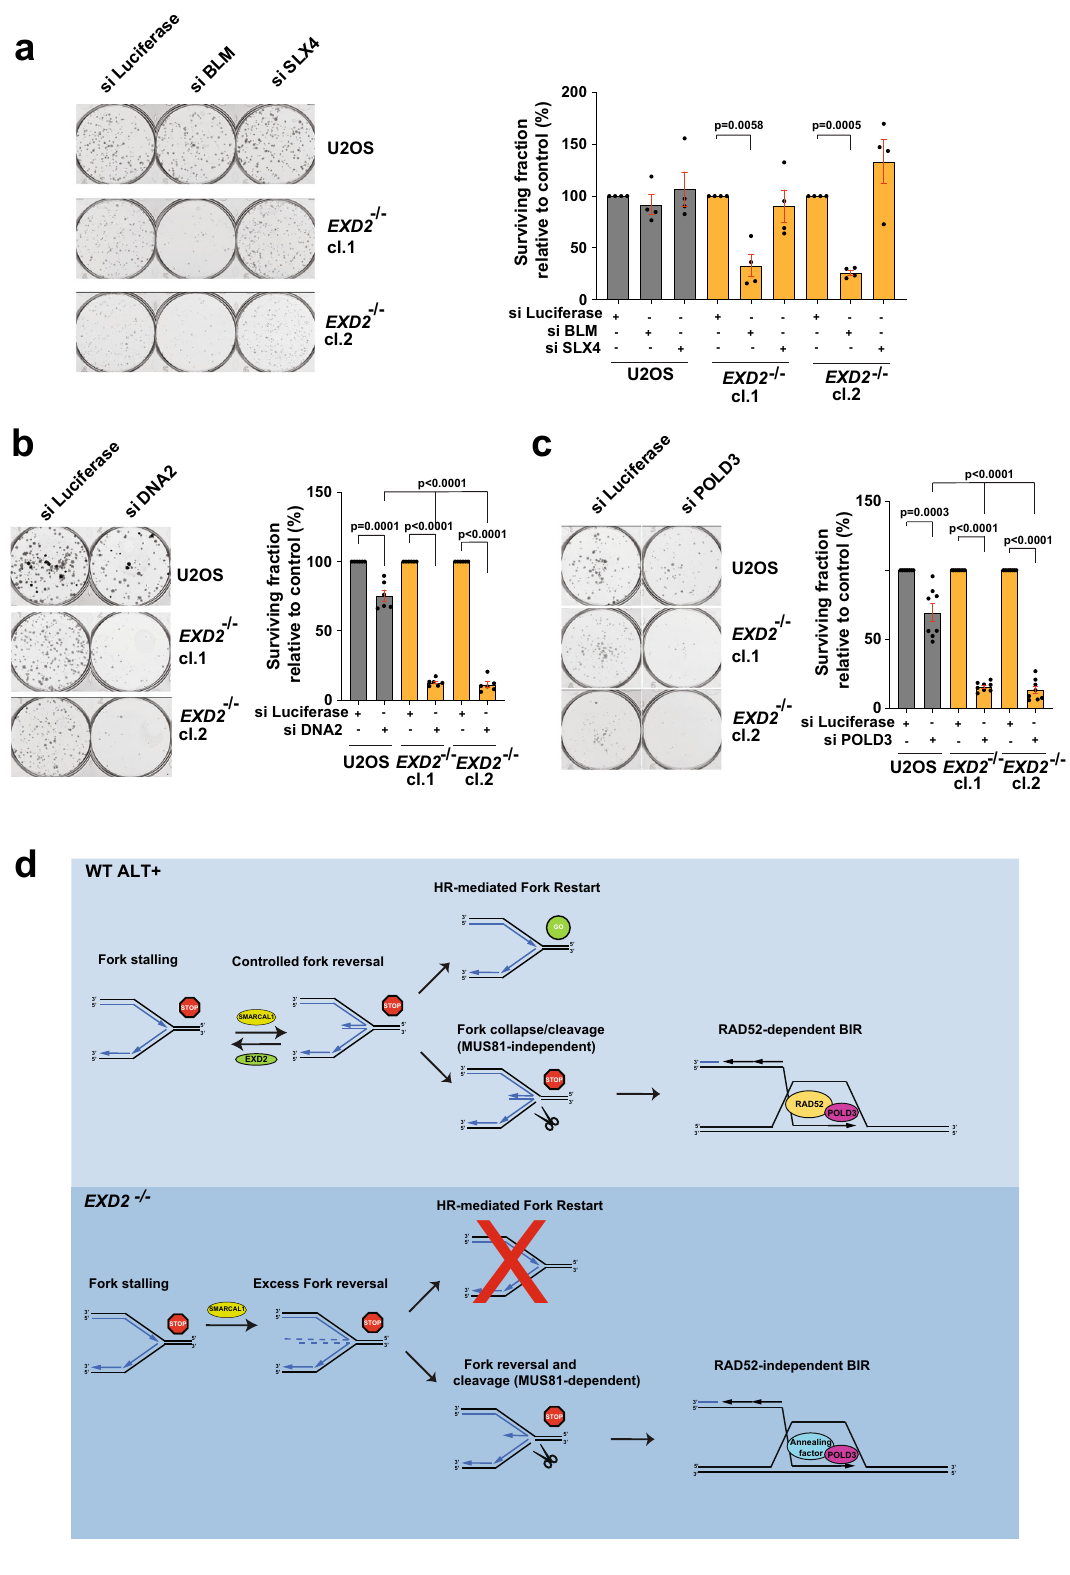
cellswascarriedoutincollaborationwithGenomicVision.Brie fl y,cells